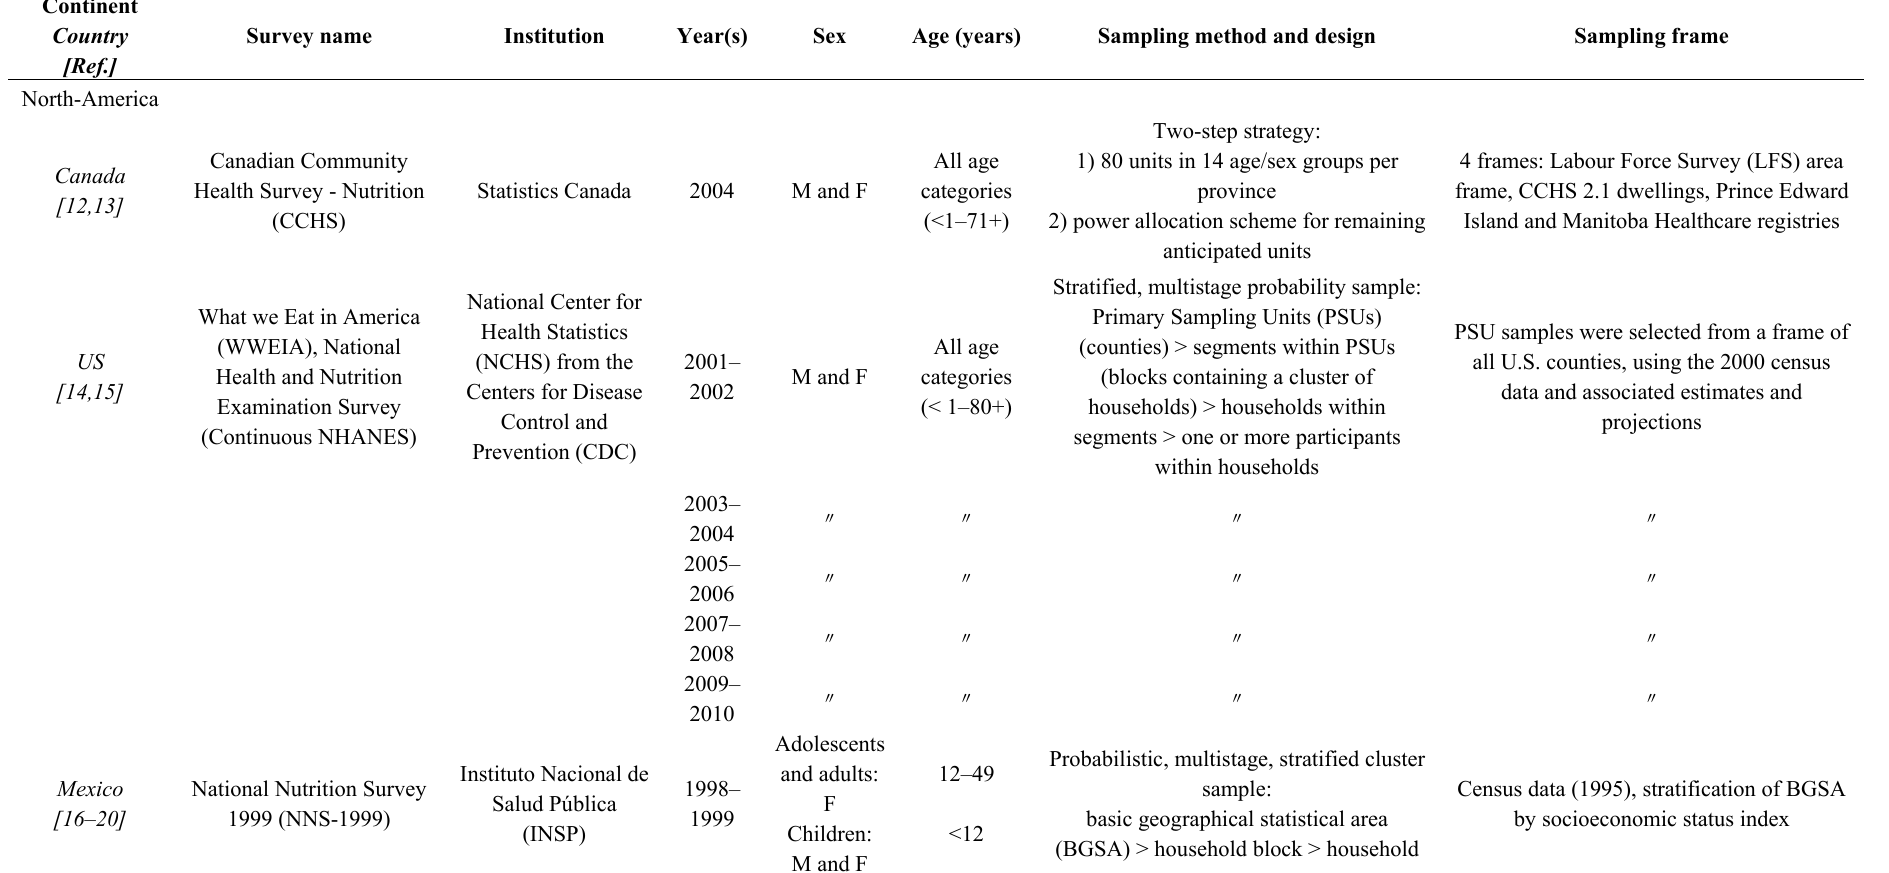
Table 2. Target population, survey design and sampling method of national nutrition surveys per